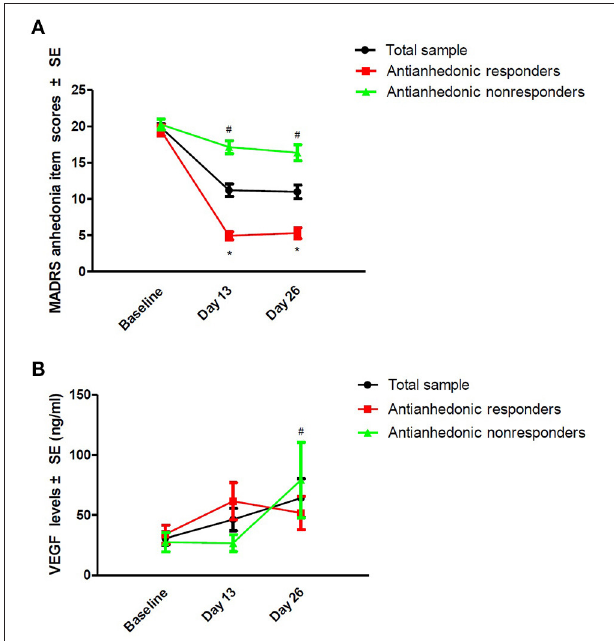
FIGURE 1 | Change in anhedonia symptoms (A) and plasma VEGF concentrations (B) in subjects suffering from TRD. # Significant difference was found when compared to baseline at the indicated times ( p < 0.05). *Significant difference was found between antianhedonic responders and non-responders at the indicated times ( p < 0.05). MADRS, the Montgomery-Asberg Depression Rating Scale; SE, standard error; TRD, treatment-refractory depression; VEGF, vascular endothelial growth factor.